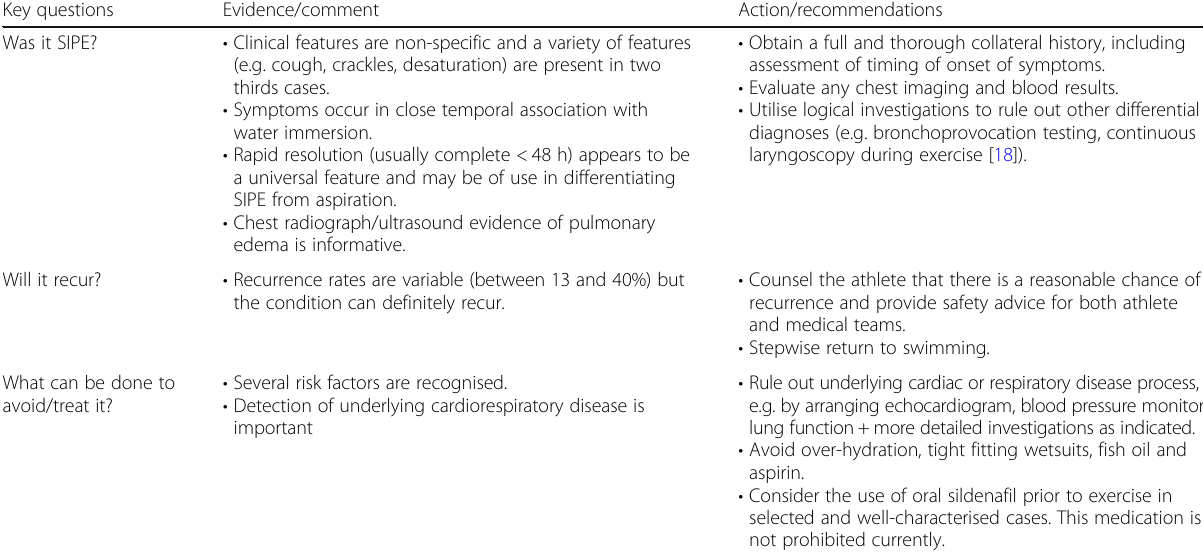
Table 1 Key considerations for the clinician addressing an athlete with probable swimming-induced pulmonary edema